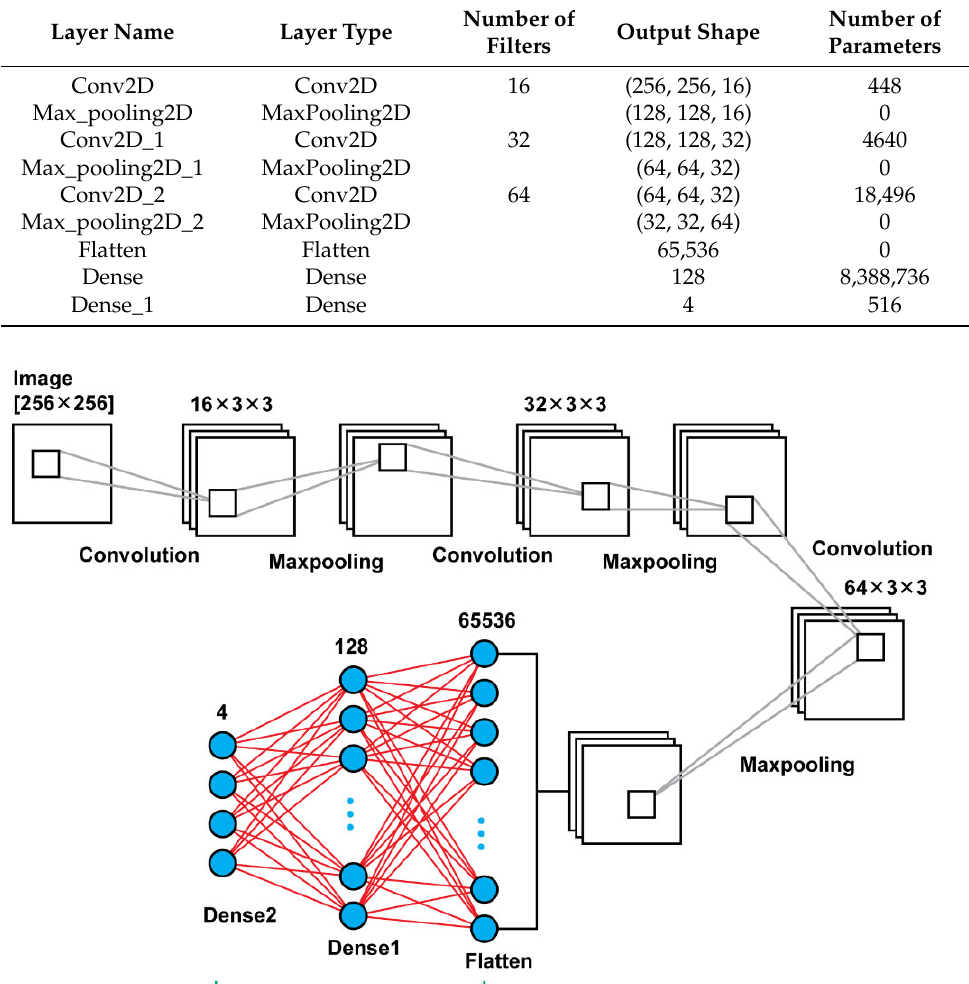
Table 1. Model 1 summary.